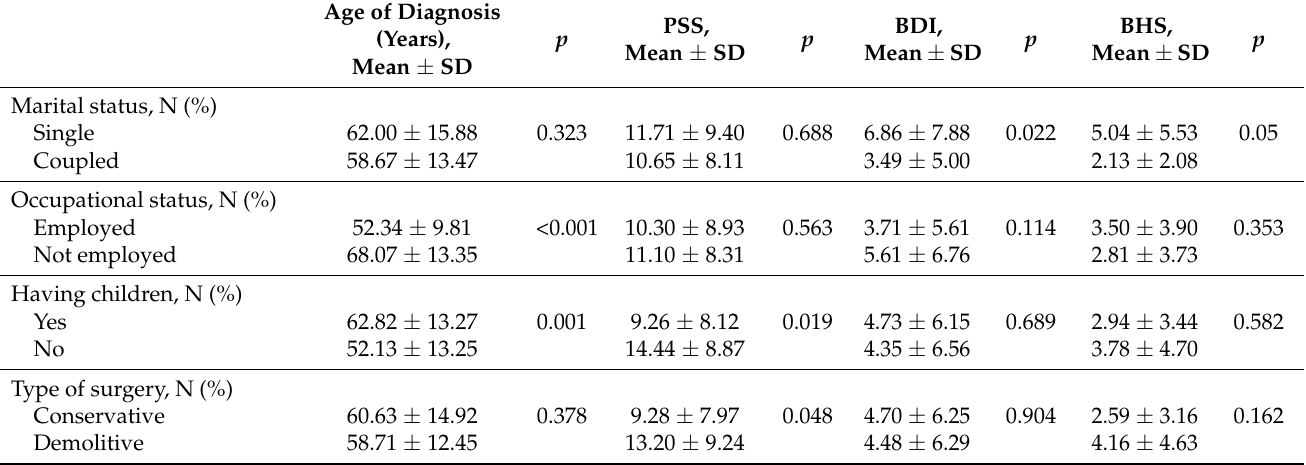
Table 2. Comparison of continuous variables between subgroups (non-parametric Mann–Whitney